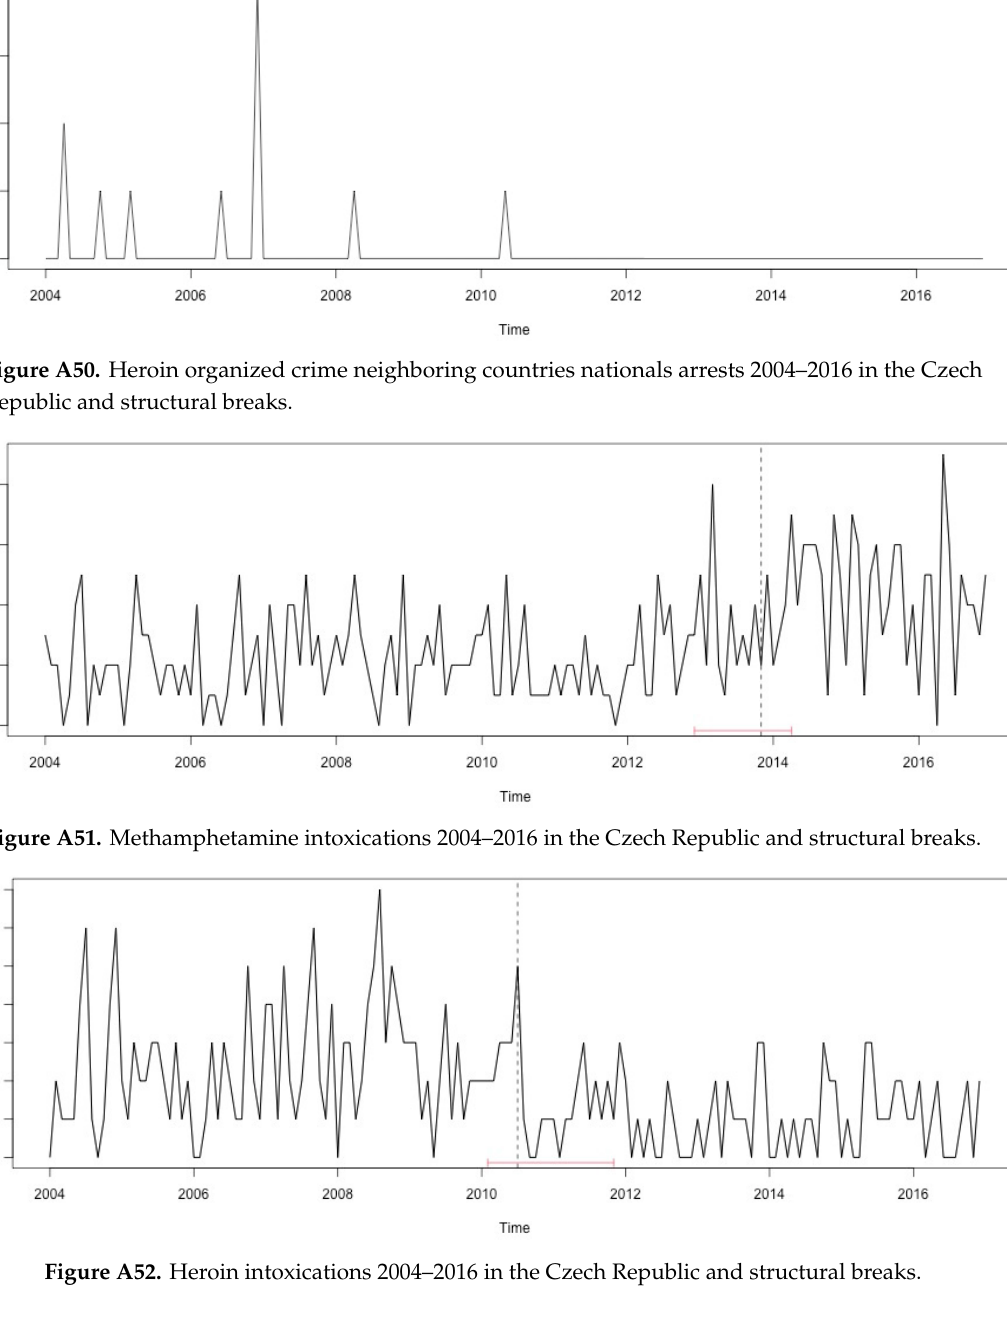
Figure A52. Heroin intoxications 2004–2016 in the Czech Republic and structural breaks.